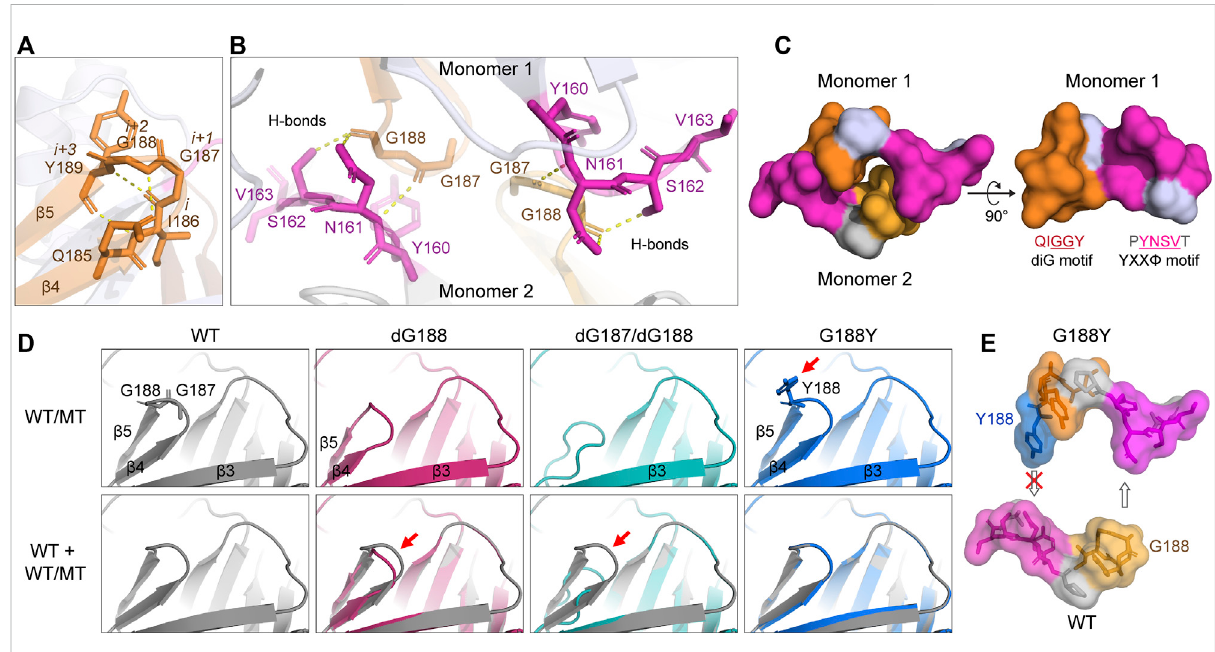
FIGURE 5 Predicated interaction of the diG motif with the YXX Φ motif. (A) Four residues, I186, diG motif (G187 and G188), and Y189, form a type II β -turn between β 4 and β 5 sheets. The hydrogen bonds were indicated with yellow dash lines. (B) The diG motif (G187 and G188) interacts with N161 and S162 residues of the YXX Φ motif of opposite monomer. (C) The diG motif and the YXX Φ motif from opposite monomers in the dimer forms a “ hand- in-hand ” shape structure. Only the aa 159 – 164 (PYNSVT) and 185 – 189 (QIGGY) containing YXX Φ and diG motifs (underlined) are shown. (D) Predicted protein structures of diG motif mutations (top panel) and their alignments with WT ORF3a (bottom panel). Red arrows indicate the major differencesbetweenWTand mutants. The proteinstructure waspredicted usingtheSWISSMODELprogram. 7KJR wasused as thetemplate. (E) The prominent aromatic side chain of Y188 blocks the formation of the “ hand-in-hand ” structure. All the protein 3D structures were visualized with PyMOL. All the images were prepared using Adobe Illustrator